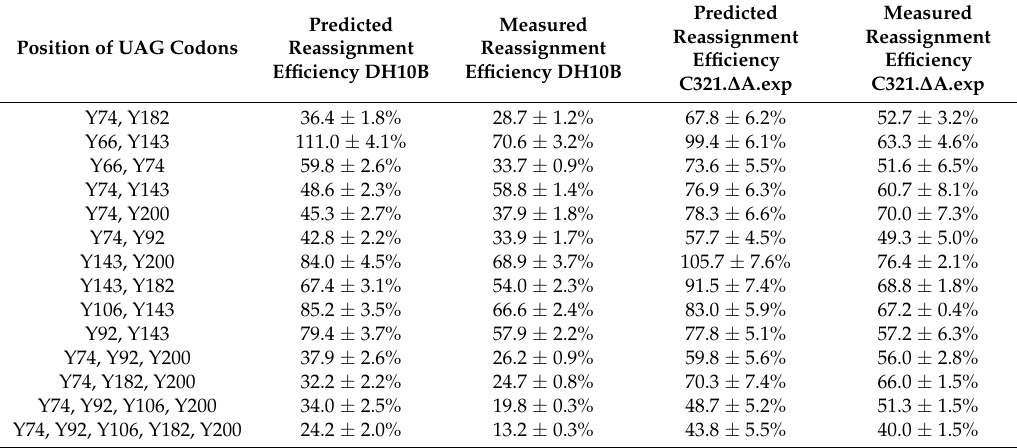
Table 2. Predicted and measured UAG reassignment efficiencies for reporter variants containing multiple amber stop